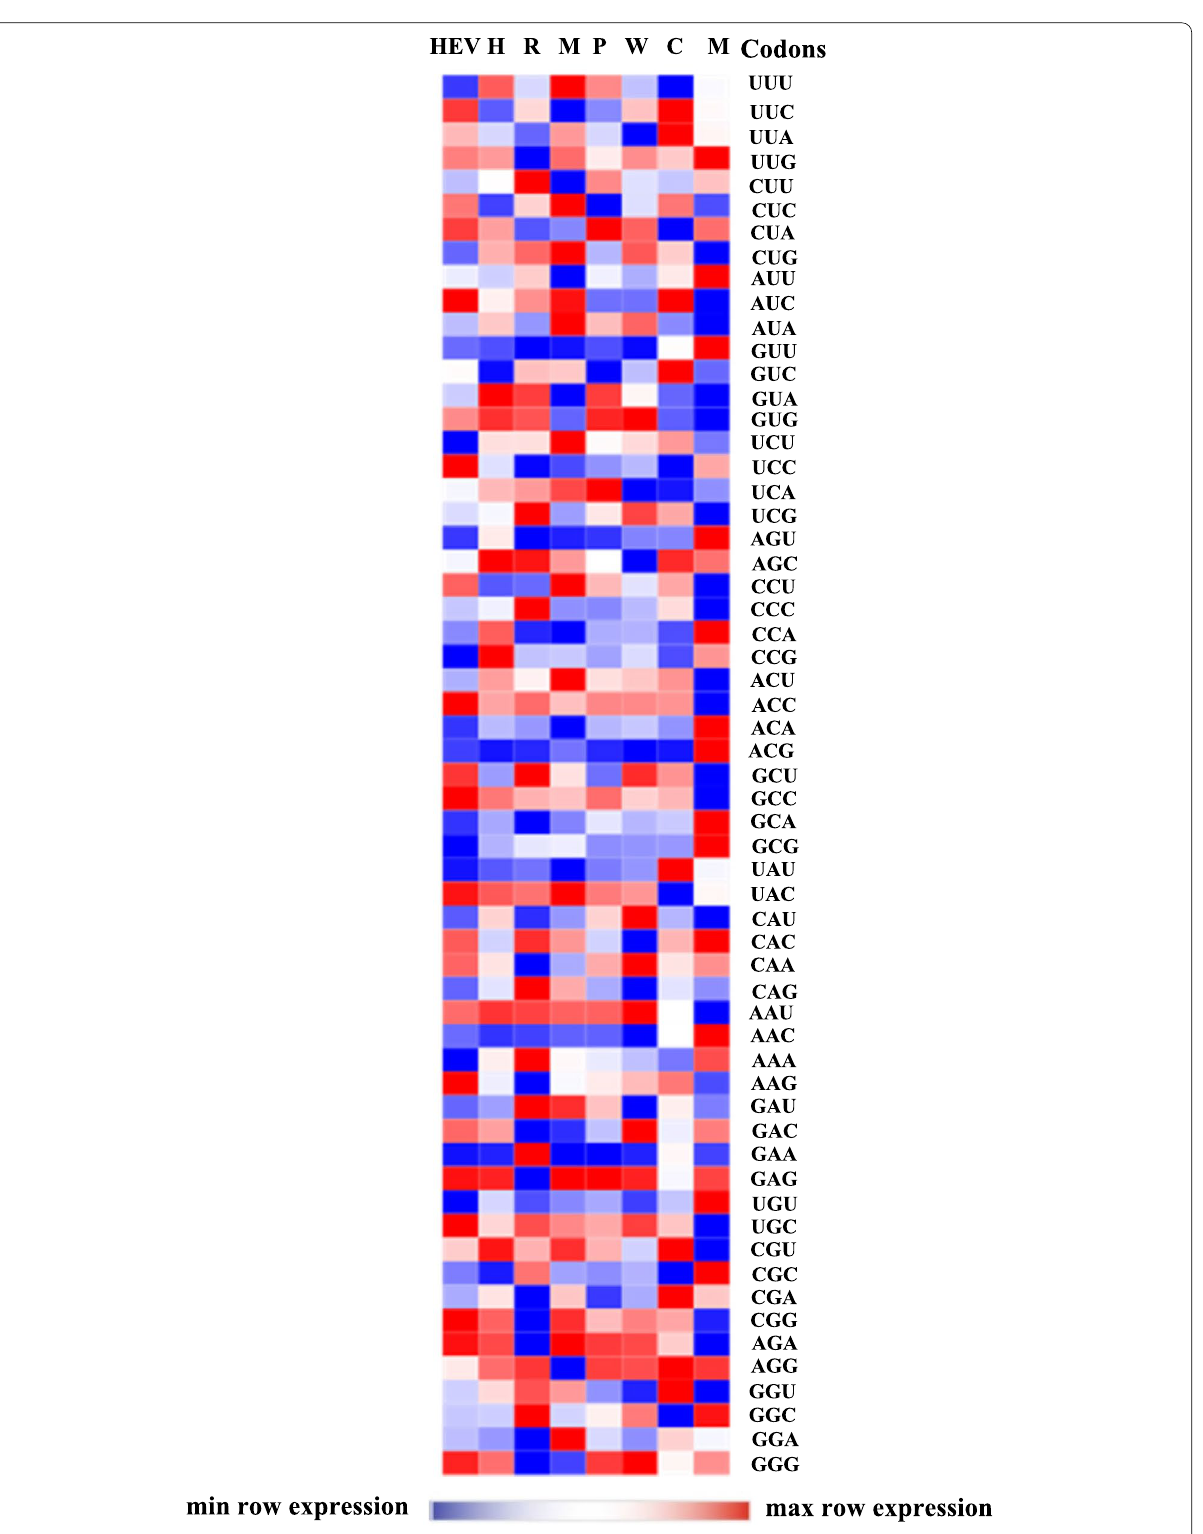
Fig. 3 Heat map showing the relative synonymous codon usage (RSCU) values accompanying different hosts (H: human, R: rabbit, M: mongoose, P: pig, W: wild boar, C: camel, and M: monkey). The host species are mentioned on the horizontal axis and codons are represented on the vertical axis. Heatmap confirms the occurrence of resemblance as well as discrepancies in RSCU pattern among different